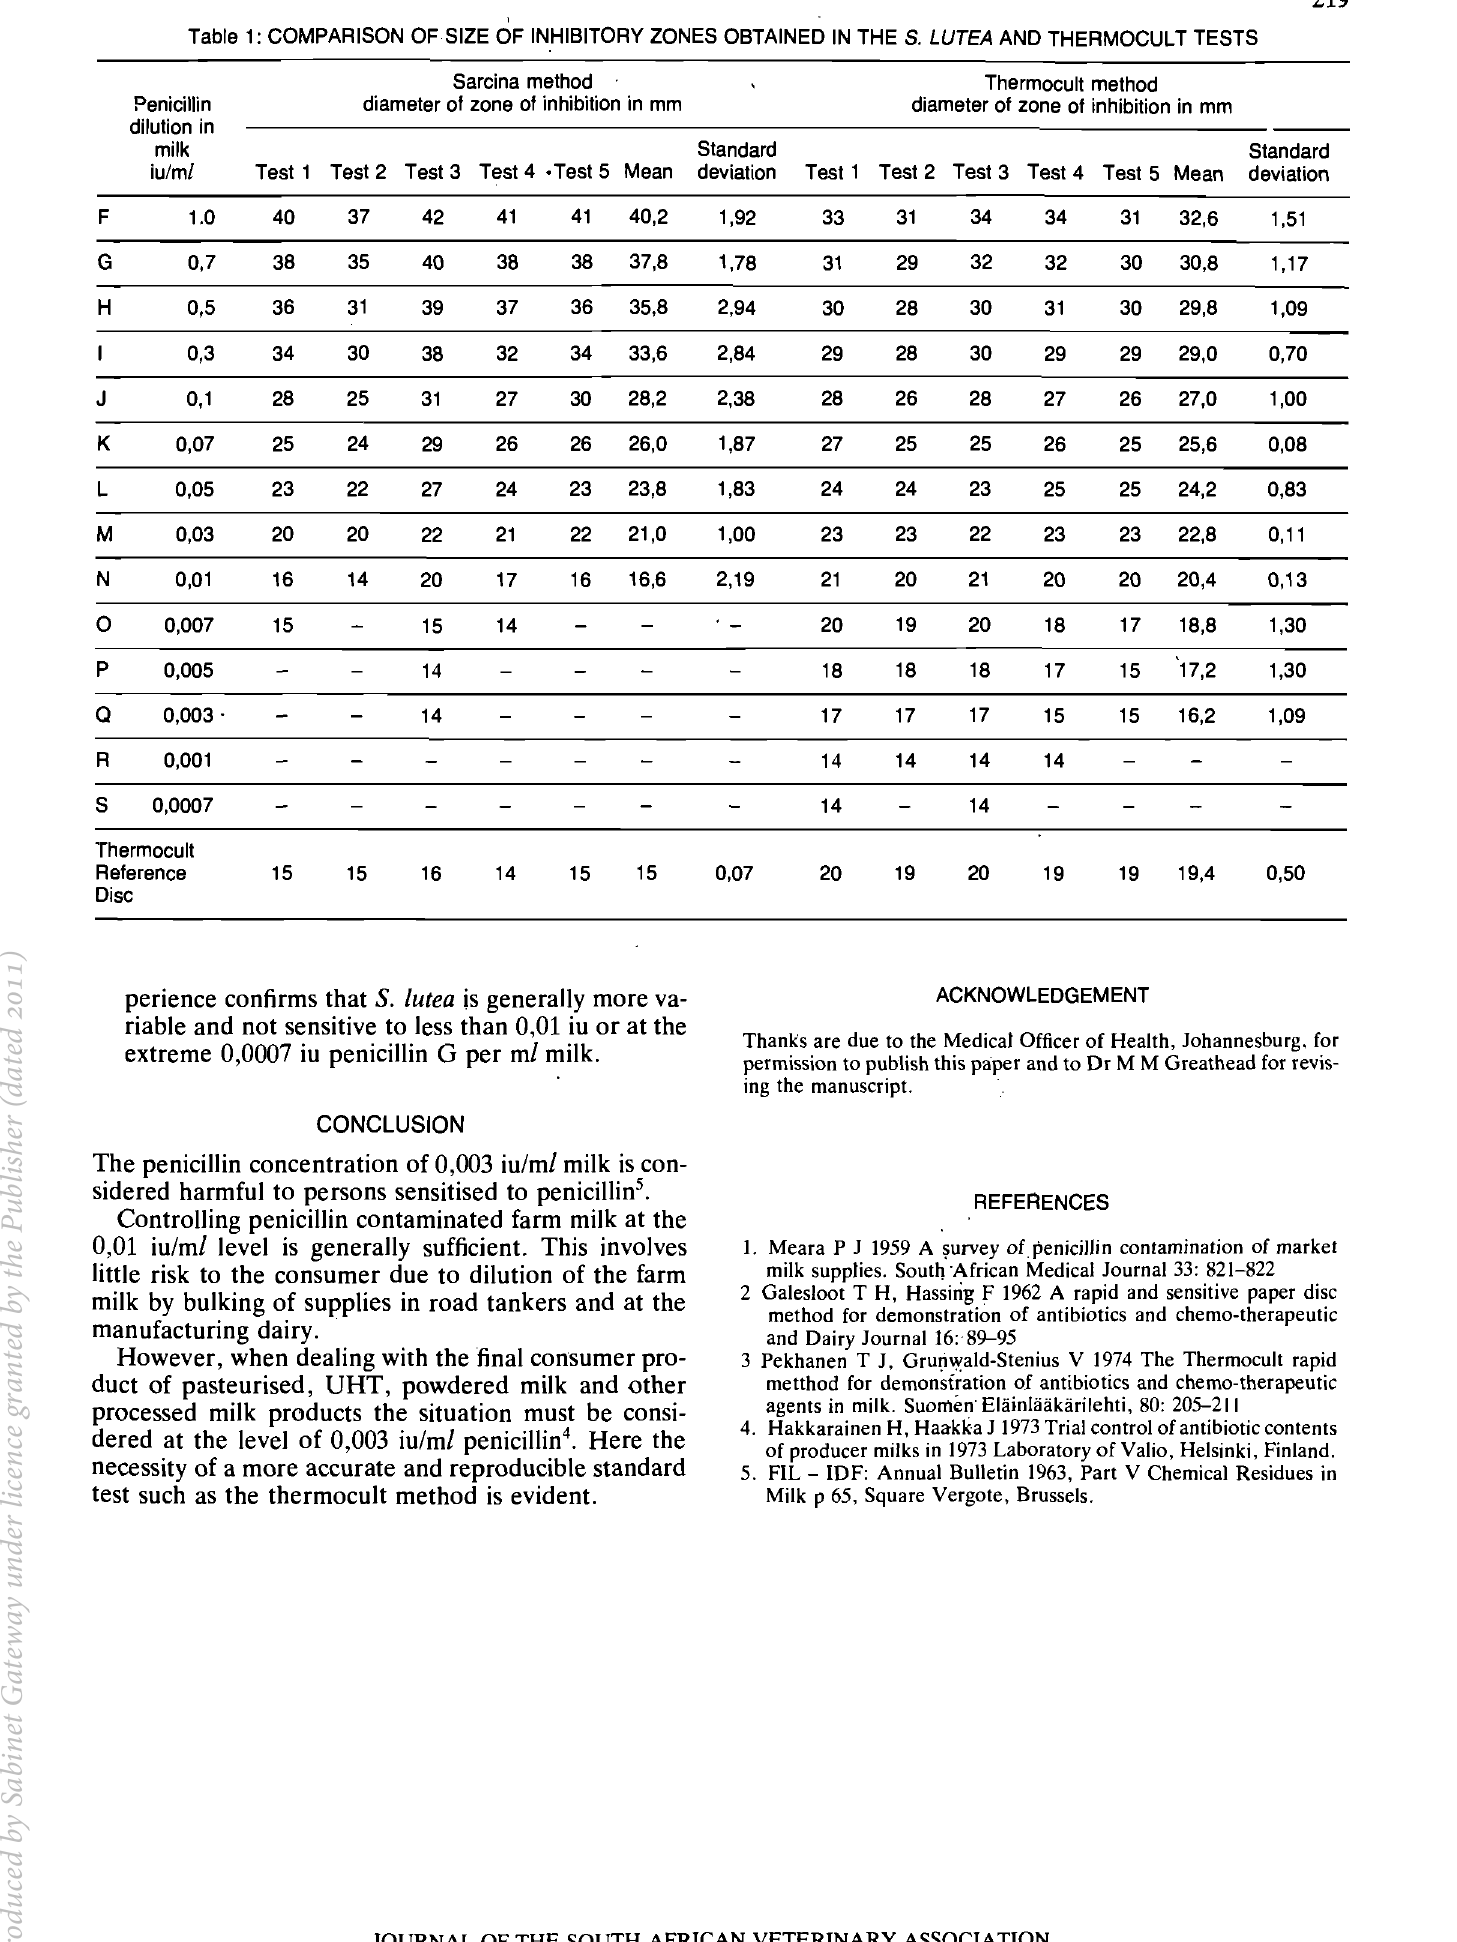
Thermocult method diameter of zone of inhibition in